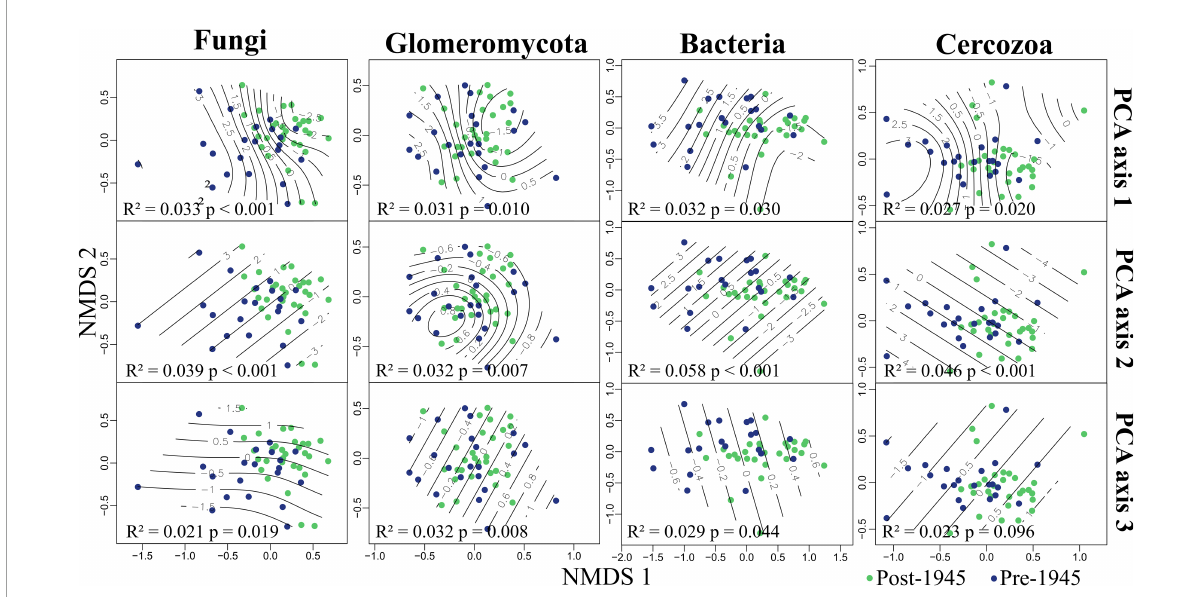
FIGURE3 Grassland microbial communities in Berlin, plotted in relation to environmental variation. Non-metric multidimensional scaling (NMDS) plots showing fungal (2D stress = 0.16), Glomeromycotan (2D stress = 0.27), bacterial (2D stress = 0.12), and Cercozoan (2D stress = 0.13) communities segregated by environmental principal component analysis (PCA) axis scores. Reported in each plot are the statistical outputs of marginal PERMANOVA models. Sites are colored by age, the PERMANOVA results for site age are: Fungi, R 2 = 0.021, p = 0.216; Glomeromycota,